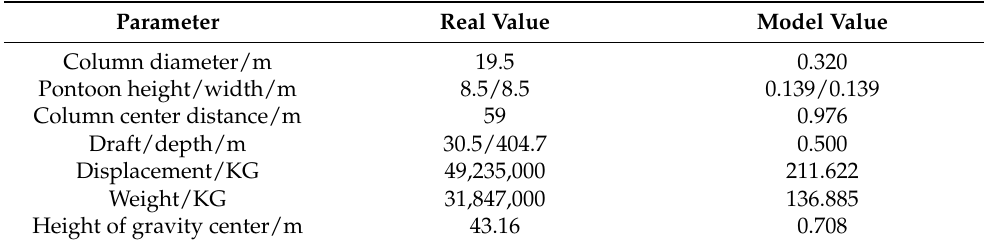
Table 1. Tension Leg Platform and Model Scale